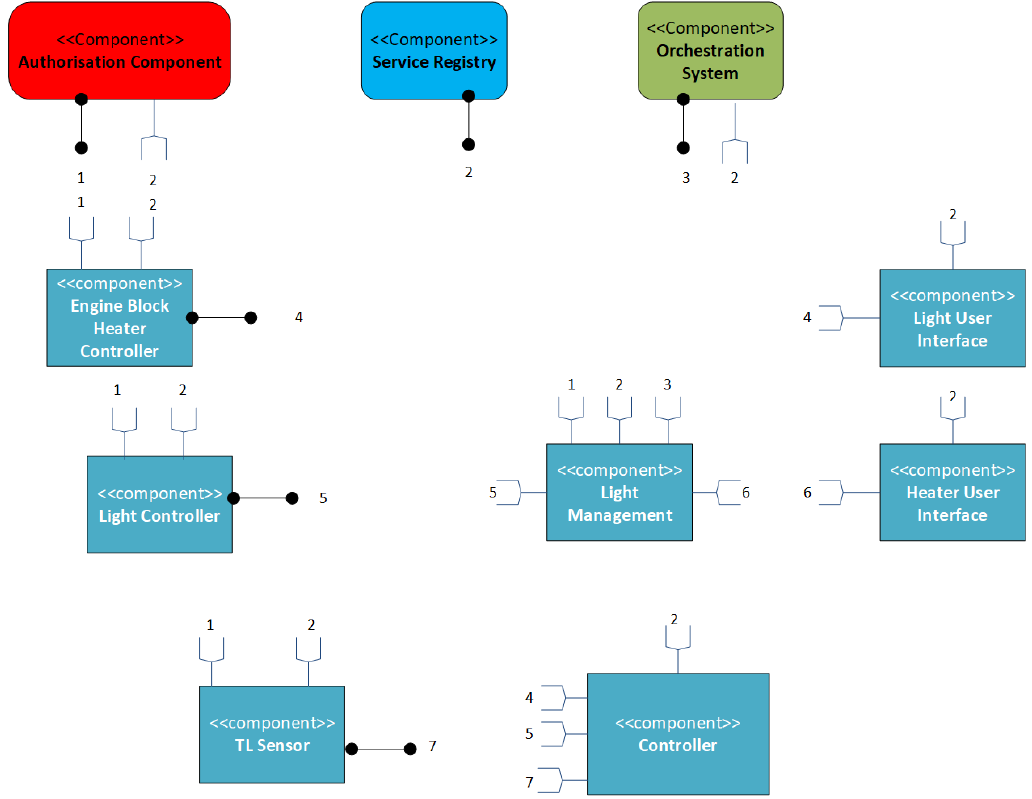
Figure 16. Overall system with street lighting and car heating system [56].